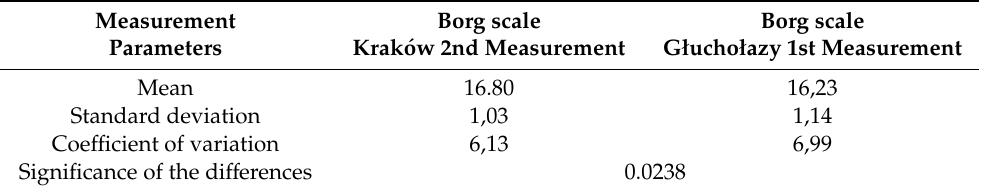
Table 4. Assessment of the subjective level of fatigue of the tested individuals in the 6MWT for the second study in Krakow and the first study in